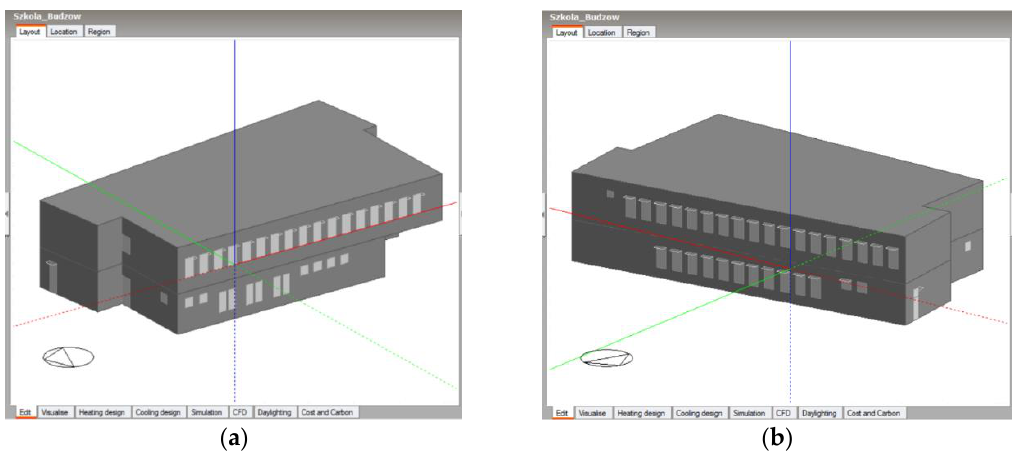
Figure 3. ( a ) South-west elevation, ( b ) North-east elevation of a passive primary school building in Budzów generated in Design Builder.